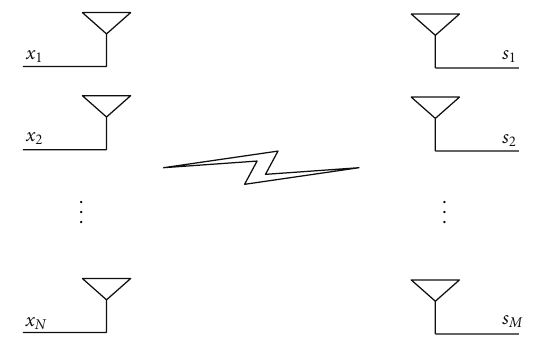
Figure 1: MIMO system with N transmit and M receive